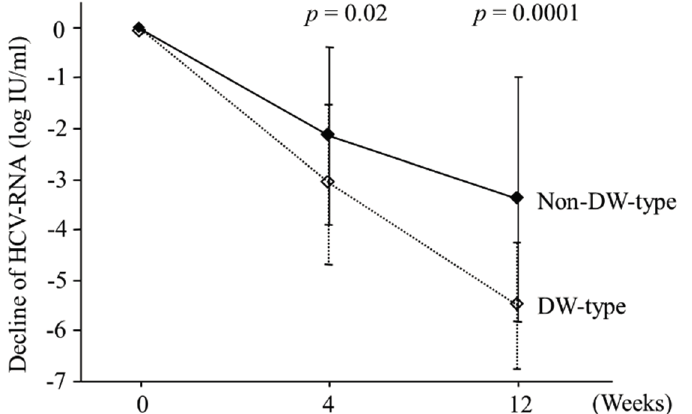
Figure 2. Viral kinetics according to amino acid mutations in the core region of hepatitis C genotype 1b patients treated with peginterferon plus ribavirin combination therapy. The mean decline in hepatitis C virus (HCV) RNA levels from baseline to weeks 4 and 12 during therapy are plotted. Vertical bars with terminal horizontal bars express standard deviation. Double wild (DW)-type: arginine and leucine at positions 70 and 91; non-DW-type: the other patterns of amino